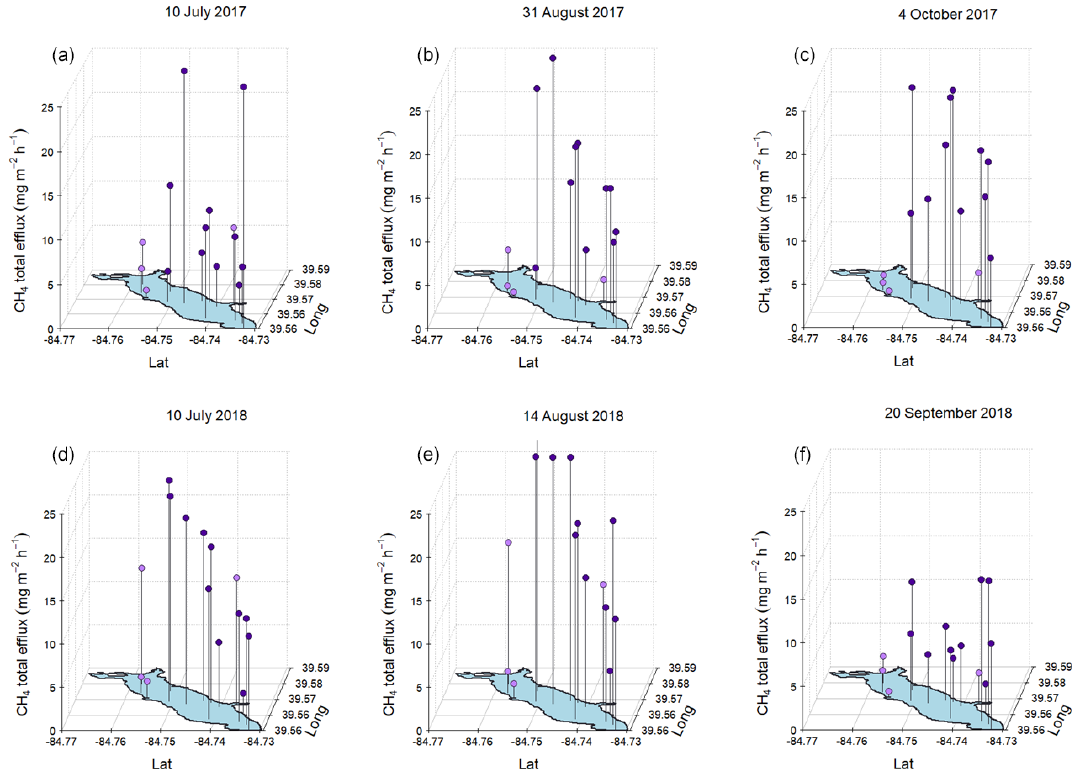
Figure 6. Total (ebullitive + diffusive) F CH measured during mid-summer, late-summer, and fall spatial surveys at Acton Lake during 4 2017 (a, b, c) and 2018 (d, e, f) . Dots indicate magnitude of F CH per the z -axis scale, and vertical black lines connect red dots to their 4 corresponding sampling location. Dot color indicates whether a sampling site is in the shallow ( < 3m, lavender) or deep ( > 3m, royal purple) area of the